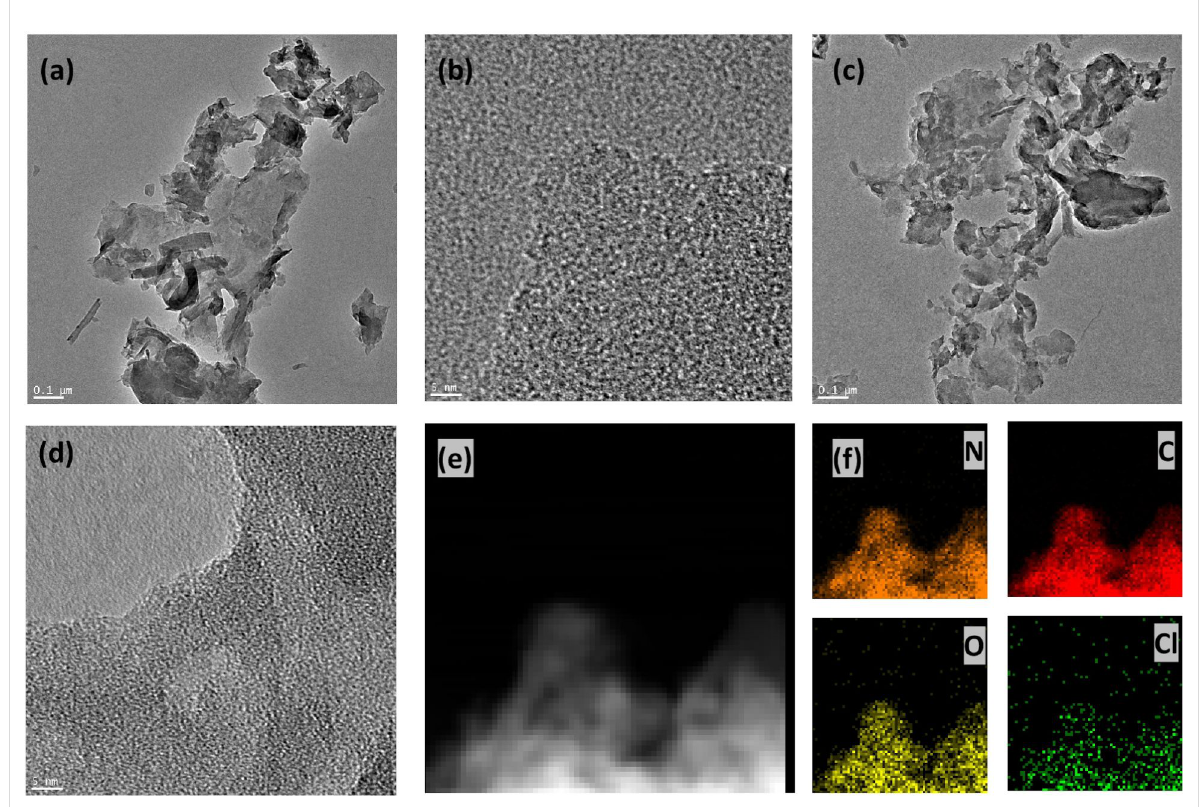
Figure 1: TEM images of PCN (a, b) and Cl-PCN (c, d). Scanning transmission electron microscopy image of Cl-PCN (e) and energy-dispersive X-ray spectroscopy (EDX) elemental mappings of N, C, O, and Cl in Cl-PCN (f).